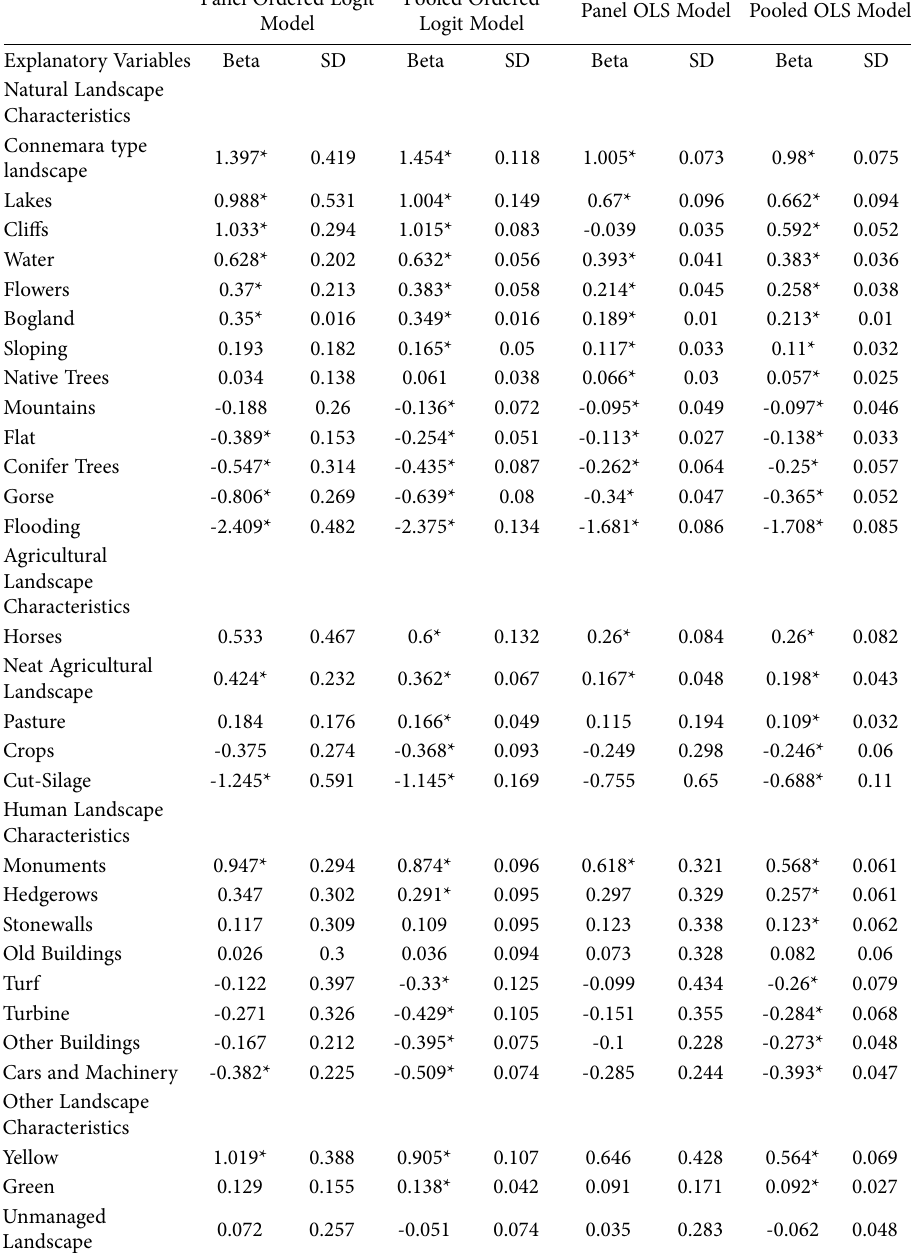
Table 6. Coefficients of Panel and Pooled Ordered Logit Model and Panel and Pooled OLS Models for Landscape